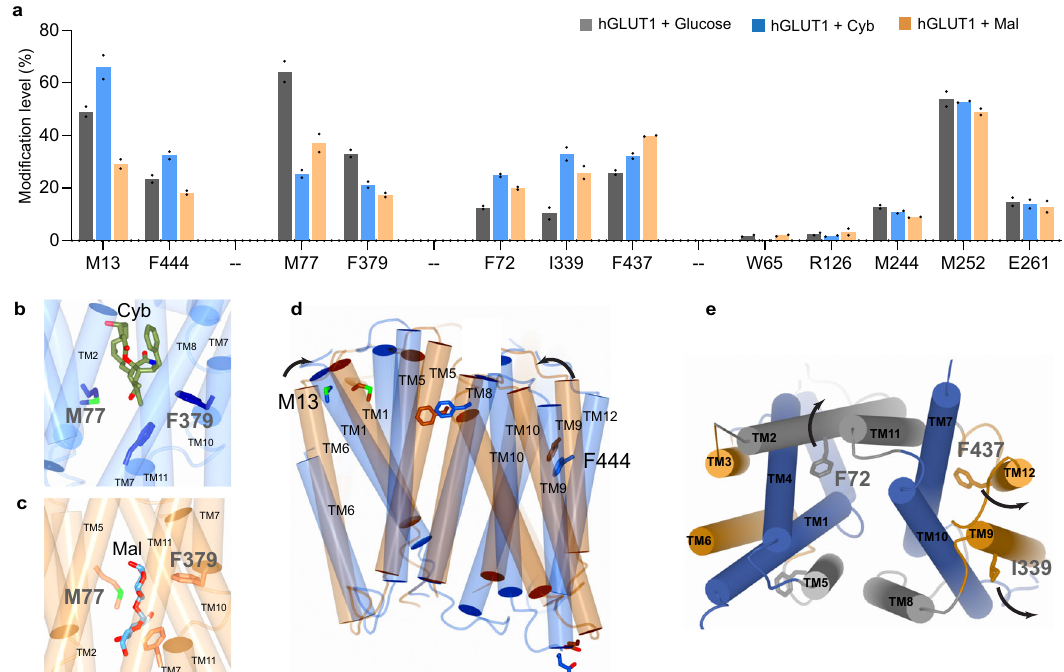
Fig. 4 NanoPOMP helps to reveal conformational change and ligands binding. a Modi fi cation extents at the residue level for three binding states of hGLUT1 (grey-hGlut1 + Glucose; blue-hGlut1 + Cyb; orange-hGlut1 + Mal). n = 2 independent experiments were repeated, two technical replicates (injections) were conducted for each individual sample. Data are presented as mean values of two biological repeats and dots represent the two corresponding biologically repeats. Source data are provided as a Source Data fi le. b , c Residues interacting with CyB and Mal as identi fi ed by NanoPOMP. d Residues reporting conformational change (indicated by arrows) from the Mal-binding state to CyB-binding state. e Residues reporting conformational changes from unbound state to CyB-/Mal-binding